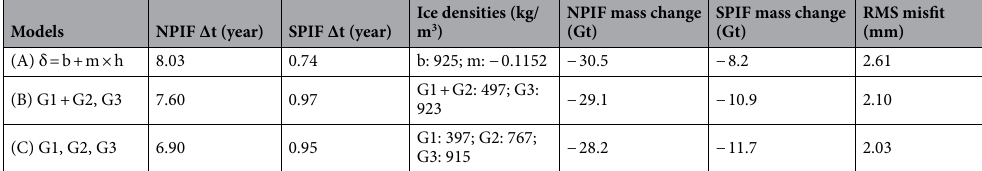
Table 1. Δt values, model results for density as a function of height (h) (A), a two-disk type classification (B), and a three-disk classification (C), NPIF and SPIF mass change and model RMS misfit.